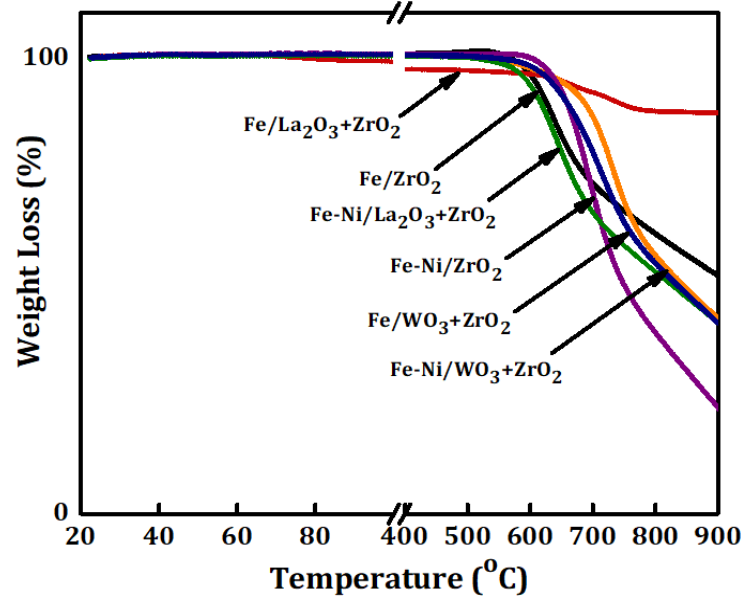
Figure 6. The thermo-gravimetric (TG) analysis results for Fe and Fe-Ni supported on x-ZrO 2 (x = 0, La 2 O 3 , WO 3 ).